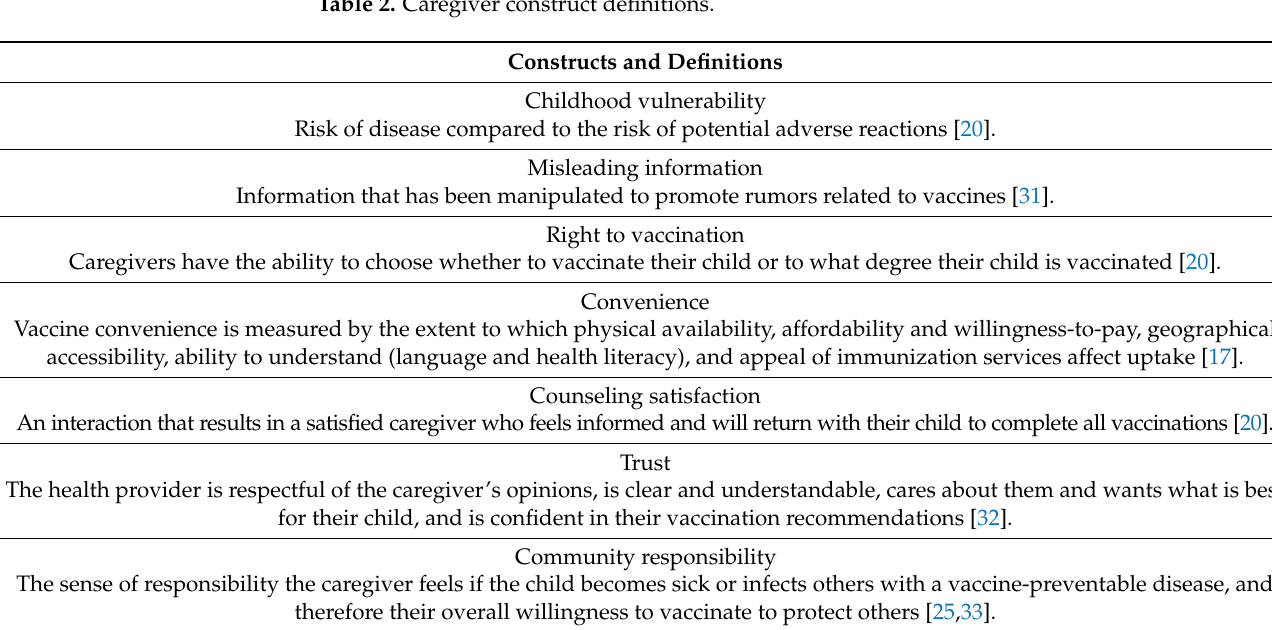
Table 2. Caregiver construct